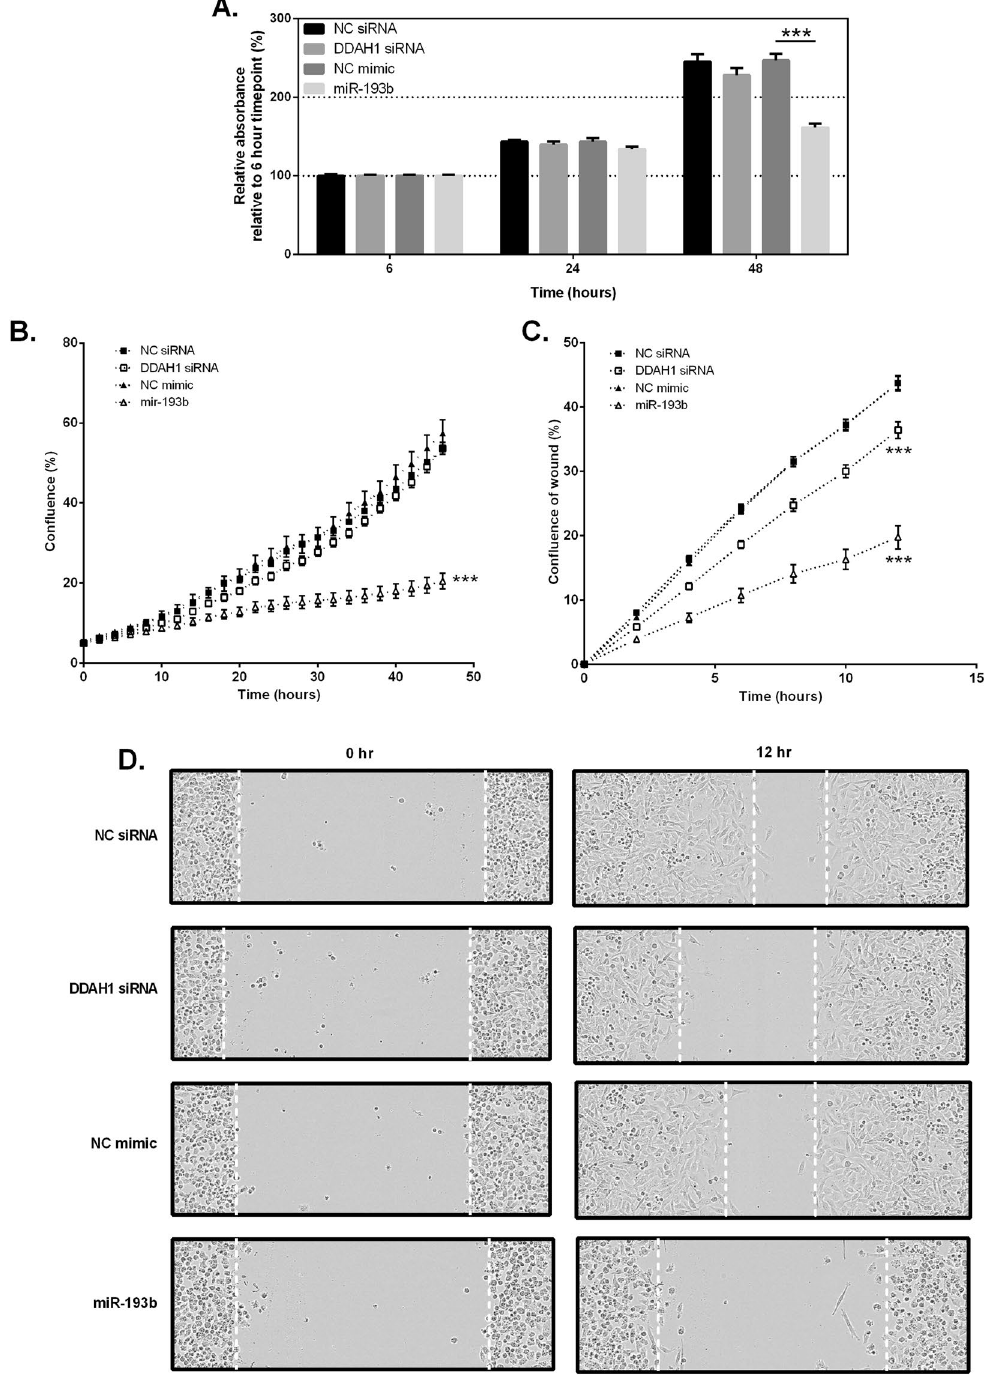
Figure 7. Effect of DDAH1 inhibition on MDA-MB-231 cell proliferation and migration. ( A ) MDA-MB-231 cells were transfected with 30 nM DDAH1-targeting siRNA, miR-193b mimic or appropriate controls and proliferation assessed by staining with crystal violet at 6, 24 and 48 hr post transfection. Absorbance was measured at 570 nm after extensive washing. ( B ) MDA-MB-231 cells were transfected with 30 nM DDAH1- targeting siRNA, miR-193b mimic or appropriate controls and proliferation was assessed using the IncuCyte ™ imaging system. Confluence was measured every 2 hr for a 48 hr period. ( C ) Scratch wound migration assays were performed with MDA-MB-231 cells using the IncuCyte ™ imaging system following generation of a wound in a confluent cell monolayer. Relative wound density was determined across 3 sections per well over a 12 hr period. Data are represented as the mean of two independent experiments performed in triplicate. Error bars represent SEM. *** p < 0.001 relative to appropriate control. ( D ) Representative images of 0 hr and 12 hr time points for transfected MDA-MB-231 cells quantified in ( C